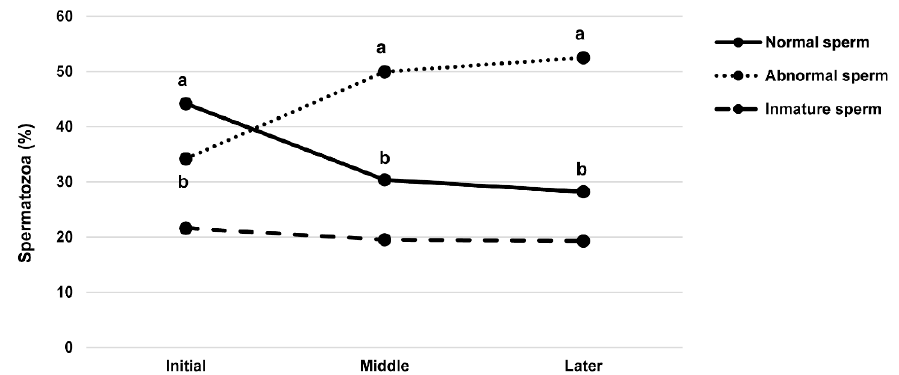
Figure 4. Percentages of the normal, immature, and abnormal sperm in falcon semen samples evaluated in the initial, middle, and later stages of the reproductive season ( n = 3258). a,b: Different letters indicate significant differences ( p < 0.05).